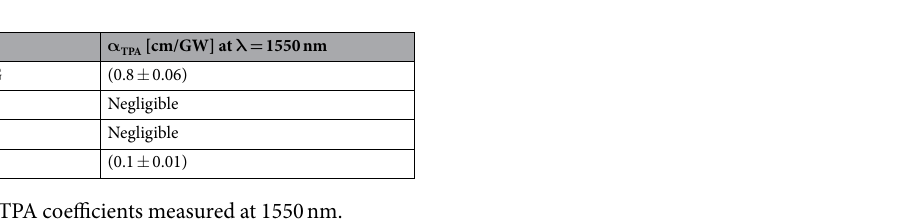
Table 3. TPA coefficients measured at 1550